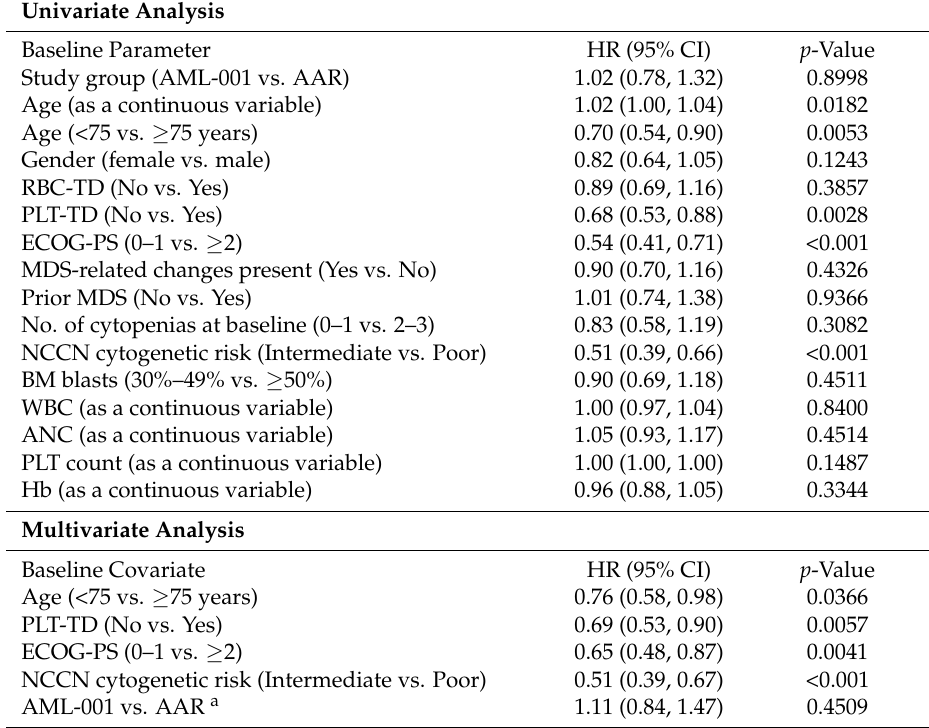
Table 4. Univariate and multivariate analysis of the effects of baseline covariates on the OS of AML patients treated with azacitidine front-line with >30% BM blasts and <15 G/L WBC within the AZA-AML-001 trial and the